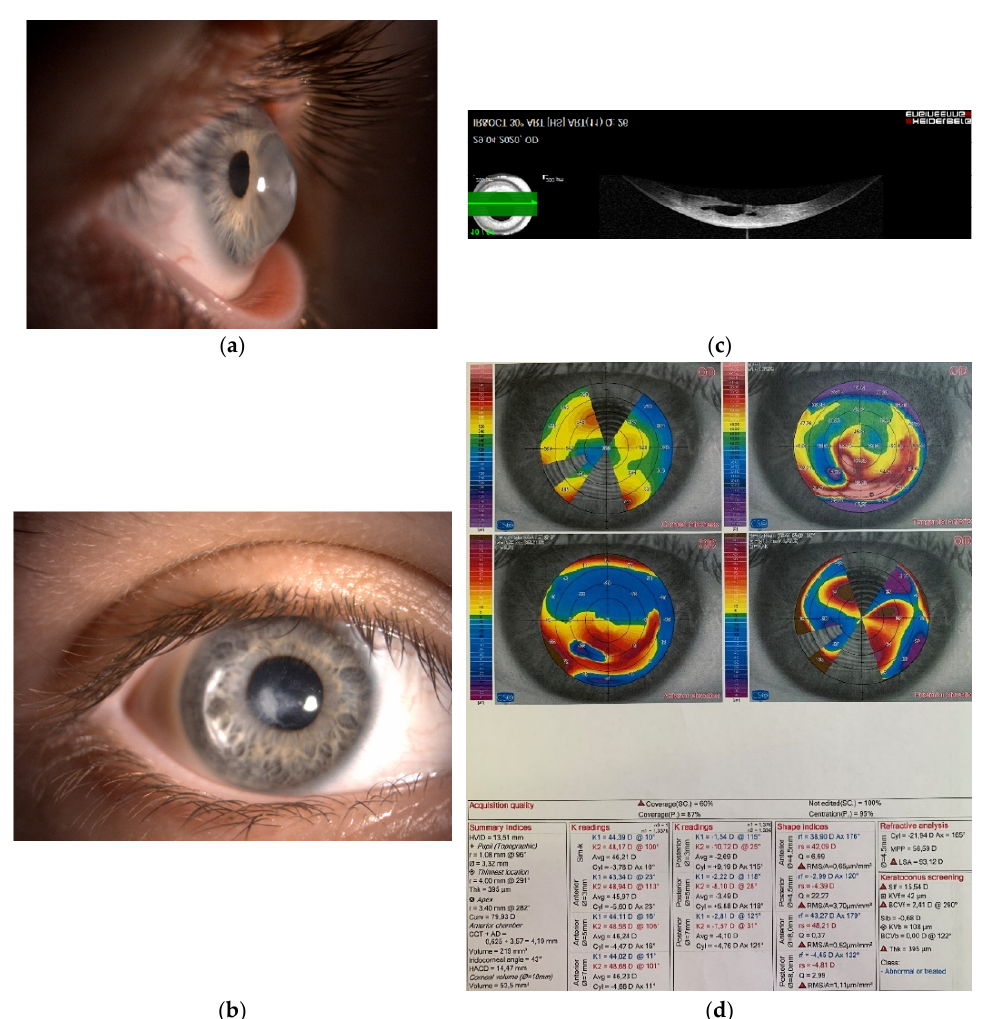
Figure 1. ( a ) and ( b ) Photography of the right cornea in a 45-year-old female patient with advanced keratoconus and visual acuity of finger counting without correction. The patient was intolerant to the rigid contact lenses. ( c ) Anterior segment optical coherence topography of the same cornea. Due to profound corneal protrusion, a break in the posterior cornea caused swelling of the stroma—called corneal hydrops. ( d ) Severe changes of the corneal topography, which were the underlying cause of severe visual deterioration.